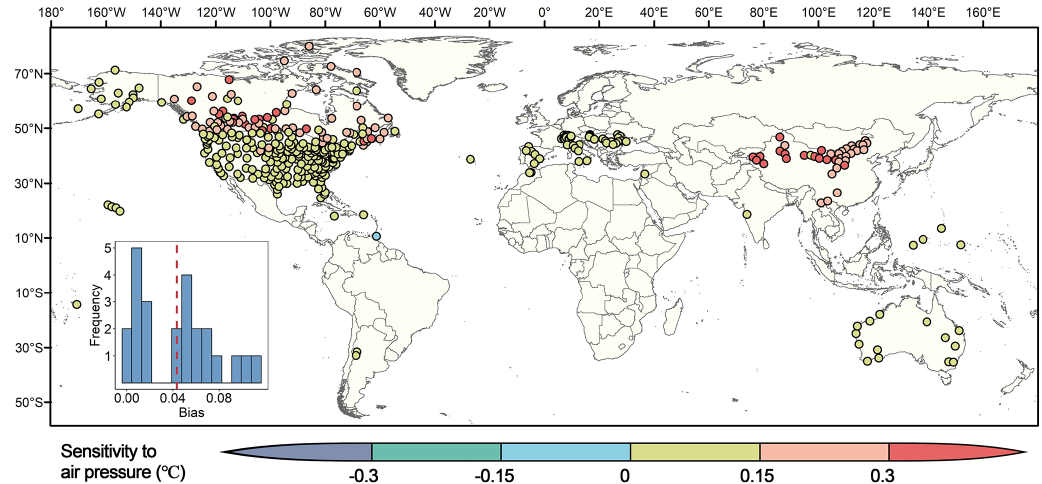
Figure 2. Sensitivity of T W to air pressure. Sensitivity, i.e., average bias, was calculated by subtracting the daily maximum T W calculated by sub-daily pressure from the daily maximum T W based on long-term average pressure. The sub-plot shows the histogram of the number of stations with corresponding average bias when average daily maximum T W was more than 20 ◦ C, where the dashed red line indicates the mean (0.04 ◦ C).